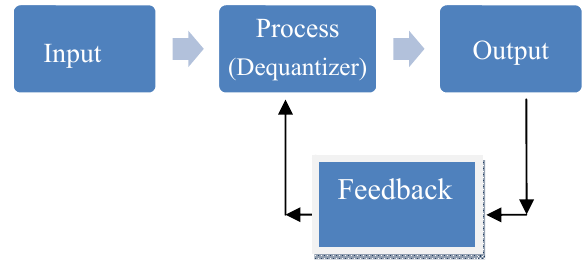
Fig. 3: Simple model of dequantization